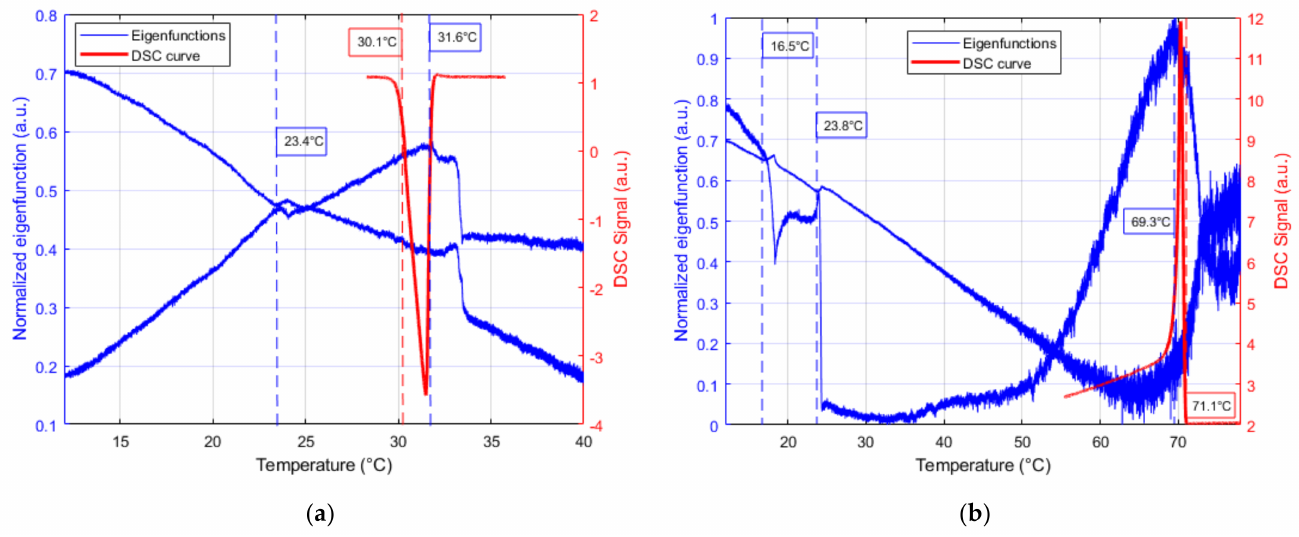
Figure 3. Third and fourth time − eigenfunctions (blue) and DSC curve for: ( a ) the sample of pure Gallium; ( b ) the Gallium − Indium